Question: Express in one sentence what the figure is showing.
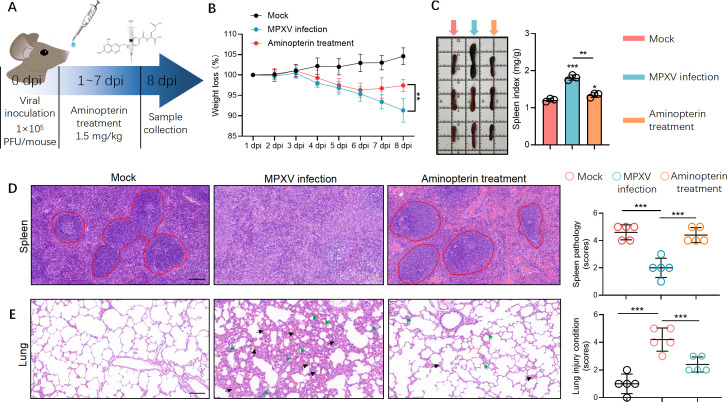
Answer: Aminopterin alleviates spleen and lung injury after MPXV infection in vivo . ( A ) Schematic of the animal experiment design. Dormice were anesthetized and infected intranasally with MPXV (total 1 × 10 5 PFU) on day 1. Aminopterin (1.5 mg/kg) or vehicle was administered via intraperitoneal injection daily from days 2 to 8. Subsequently, dormice were euthanized on day 8, and the organs were collected for analysis ( n = 5, animals, biological replicates). ( B ) The percent of body weight was monitored for 8 days among the dormice challenged with MPXV (1 × 10 5 PFU) and treated with aminopterin and vehicle, respectively ( n = 5, animals, biological replicates). ( C ) Splenic index was calculated with spleen-to-body weight ratio (mg/g; n = 3, animals, biological replicates). ( D and E ) Histopathology changes in lung and spleen tissues, respectively (scale bar: 100 μm). Quantification standards are detailed in the Materials and Methods section ( n = 5, animals, biological replicates). Red lines indicate the RP area. Green arrows indicate lymphocytic infiltration. Black arrows indicate interstitial hemorrhage. Data were expressed as means of technical replicates ± SD. One-way analysis of variance ( C, D, and E ) and SNK-q test ( C, D, and E ) were performed in this section (* P < 0.05, ** P < 0.01, and *** P < 0.001, ns : not significant).